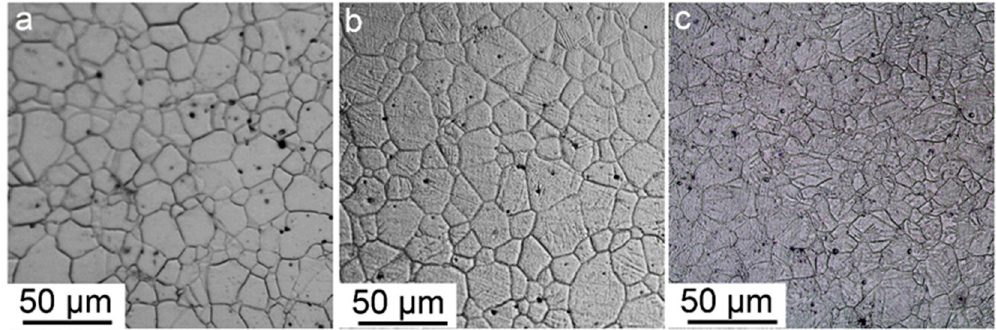
Figure 1. Optical microscope structure of di ff erent samples ( a ) AE; ( b ) F-7; ( c ) F-12.